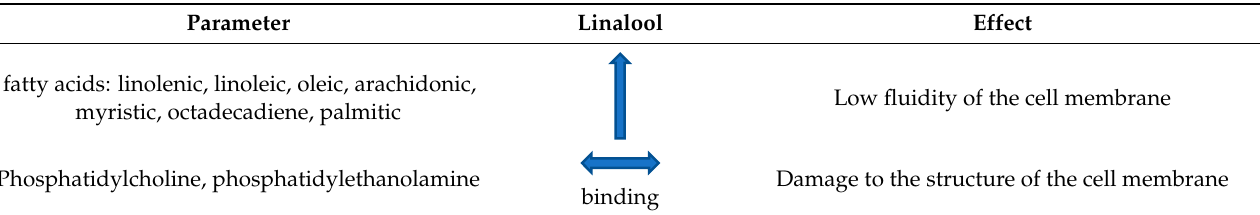
Table 6. Antimicrobial activity of linalool against fungi. Strain